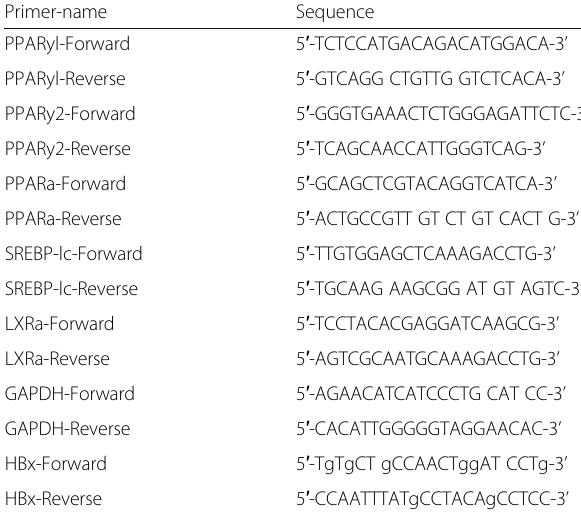
Table 1 Oligonucleotide primer sets and conditions used for semi-quantitative